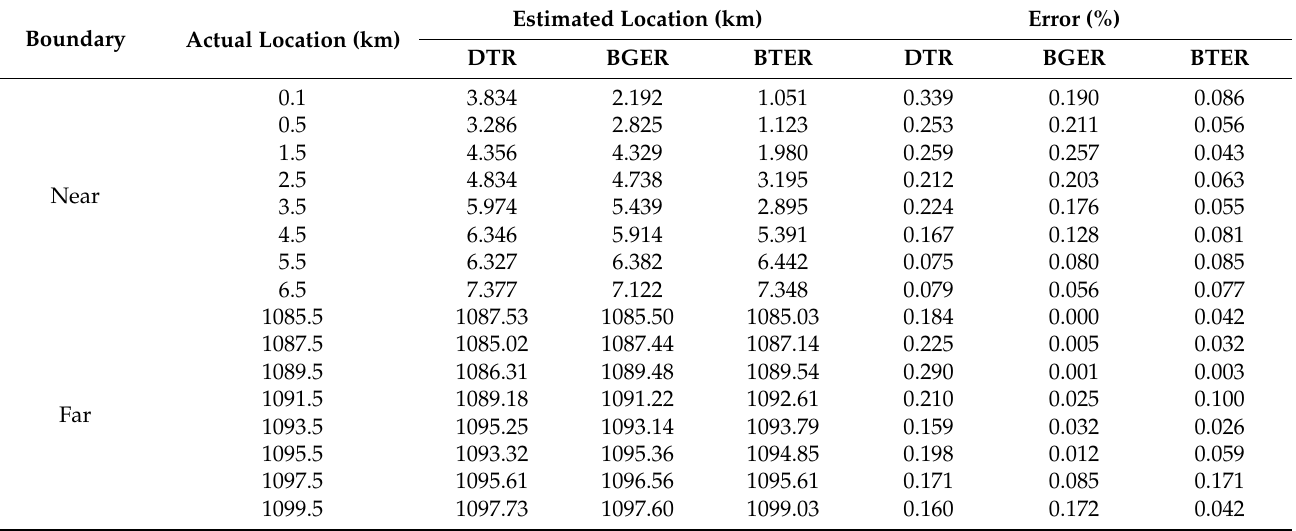
Table 3. Actual and estimated fault location.